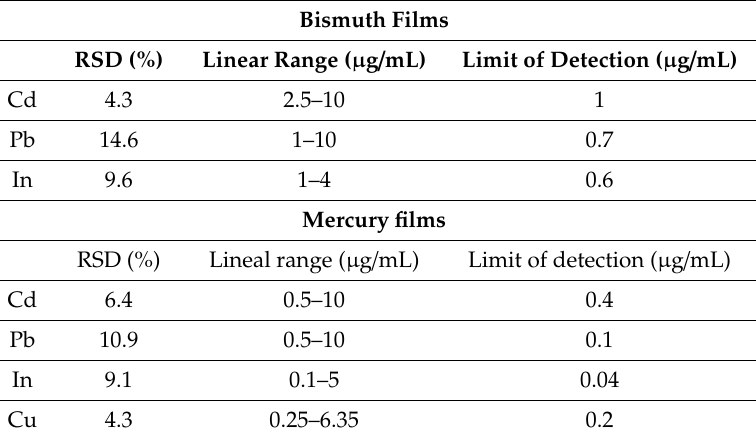
Table 1. Analytical characteristics for Cd (II), Pb (II), In (III) and Cu (II) on paper-based electrodes modified with bismuth or mercury